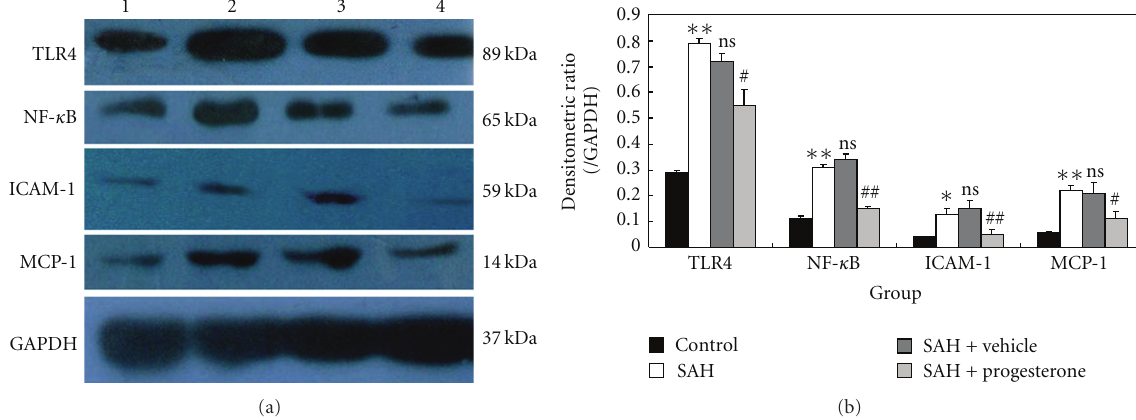
Figure 2: (a) Representative autoradiogram of TLR4, NF- κ B, ICAM-1, and MCP-1 in the cortex. We observed TLR4 at 89kDa, NF- κ B at 65kDa, ICAM-1 at 59 kDa, MCP-1 at 14kDa, and a loading control GAPDH at 37 kDa. Lane 1, control group; Lane 2, SAH groups; Lane 3, SAH + vehicle group; Lane 4, SAH + progesterone group. It shows that the expression of TLR4/NF- κ B related proteins increased after SAH and inhibited by progesterone administration. (b) Quantitative analysis of the Western blot results for TLR4, NF- κ B, ICAM-1, and MCP-1. It shows that the levels of TLR4, NF- κ B, ICAM-1, and MCP-1 in SAH groups are significantly higher than that in control. After progesterone administration, the TLR4/NF- κ B related agents were significantly down-regulated as compared with SAH + vehicle group. Bars represent the mean ± SD ( n = 6, each group). ∗ P < . 05 compared with control group, ∗∗ P < . 01 compared with control group, # P < . 05 compared with SAH + vehicle group, ## P < . 01 compared with SAH + vehicle group, ns P > . 05 compared with SAH group.